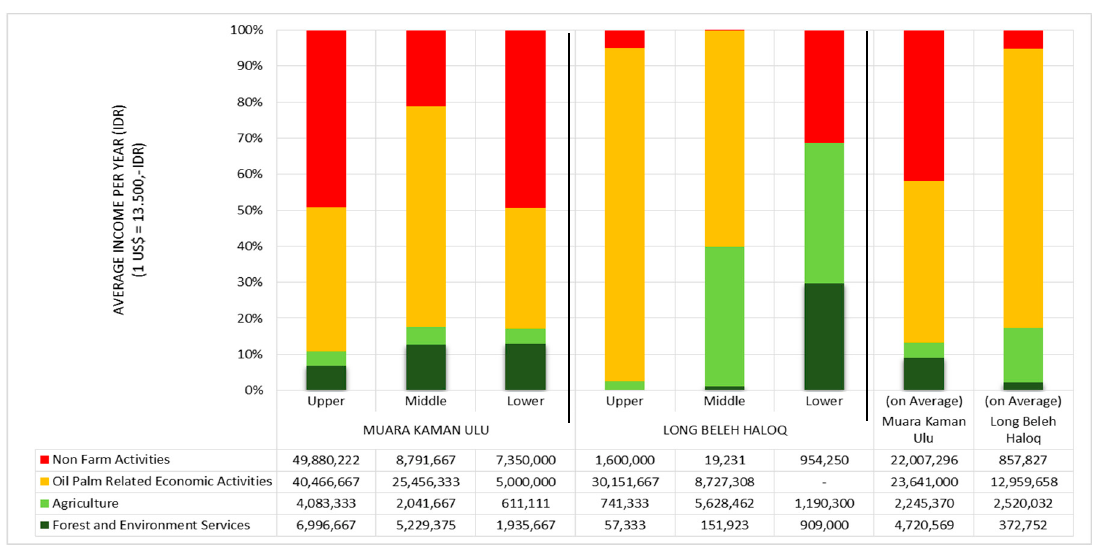
Figure 5. The income structure by strata in the villages of Muara Kaman Ulu and Long Beleh Haloq. (Source: primary data, 2016). Table 1. Index of household income diversity in Muara Kaman Ulu and Long Beleh Haloq villages, 2017.